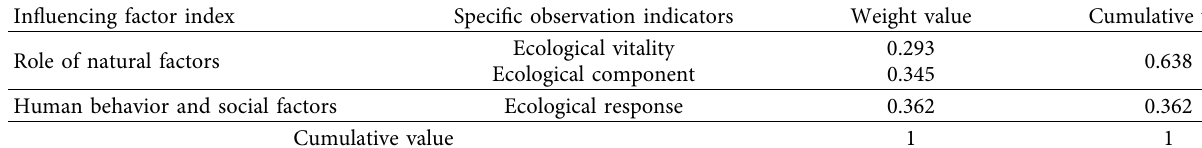
Figure 10: Remote sensing images of wetland ecological areas with different data types. (a) TM, (b) ETM + and (c) OLI. Table 3: Evaluation indicators at all levels and their weight values.